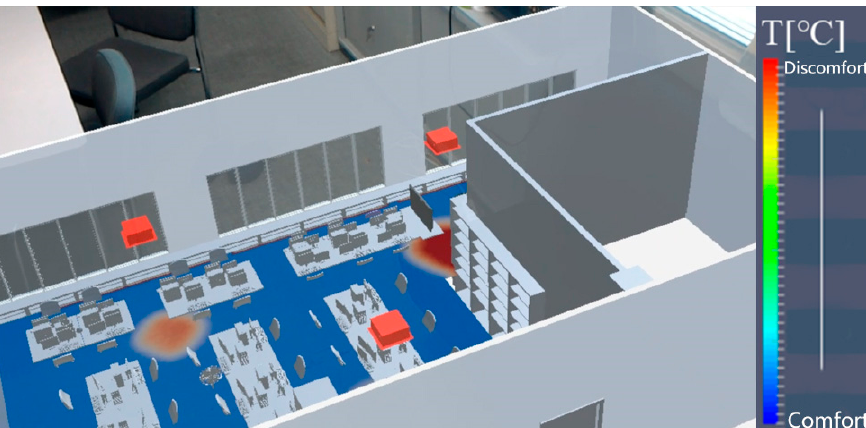
Figure 5. Heat map of room 411 small-scale model (1/10).